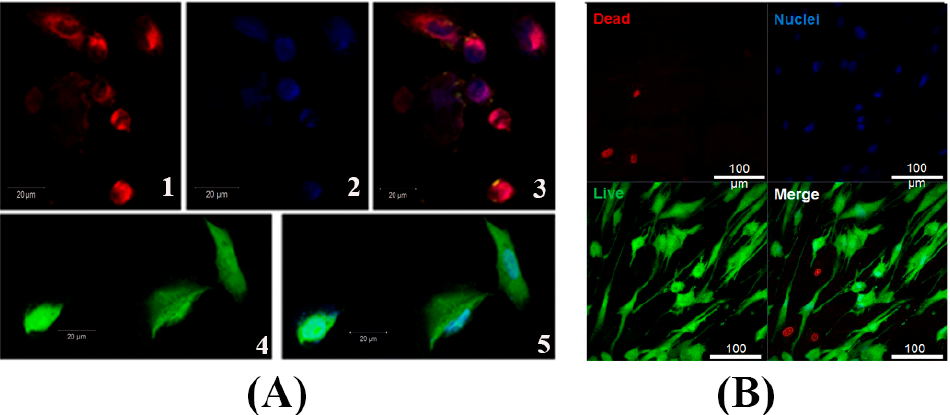
Figure 5. Results of confocal microscopy of collagen scaffold from Dosidicus gigas treated by cells stained by Mitotracker Red, DAPI, and FITC. ( A ) Fibroblasts, ( B ) viability estimation of cells. Mito- chondria are stained in red; cell nuclei are stained in blue; matrix is stained in green.